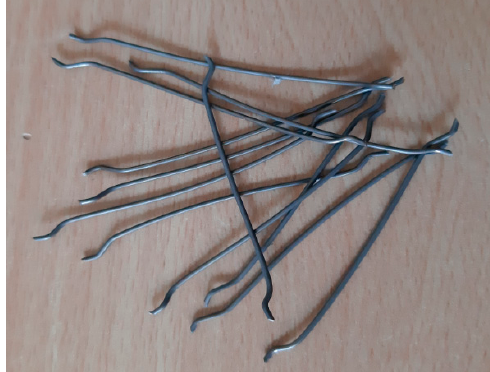
Figure 6. Fibers used for test specimens.